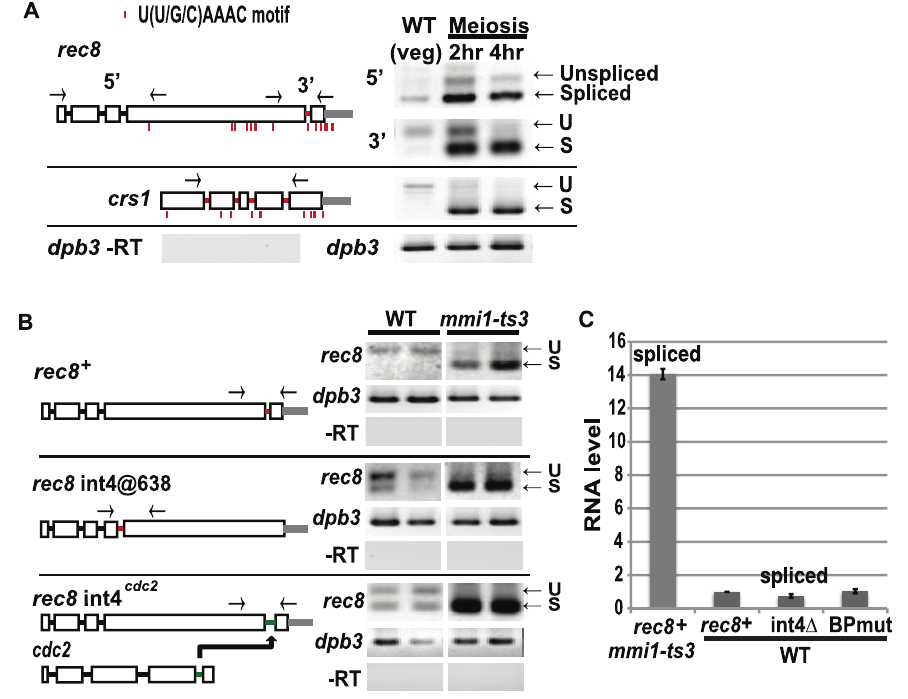
Figure 3. Splicing and stability of the rec8 transcript. (A) Splicing of endogenous rec8 and crs1 . Gene structures of rec8 and crs1 are drawn to scale. Box, exon; Black line, constitutively spliced intron; red line, regulated intron; grey line, 200 nt 3’ UTR; red bar, Mmi1 motif. The three introns clustered at the 5’ end of rec8 or the 3’-most 4 th intron were assayed with 5’ or 3’ primer pairs, respectively. All four introns of crs1 were assay with one primer pair. The dpb3 control indicates equal loading and the -RT control (no reverse transcriptase) shows the absence of contaminating genomic DNA. (B) Splicing of rec8 variants. A rec8 D (‘‘WT’’) or rec8 D mmi1-ts3 (‘‘ mmi1-ts3 ’’) strain were transformed with plasmids bearing the indicated rec8 constructs. Splicing of the 4 th intron was assayed by RT-PCR. Top, wild type rec8 + , middle, rec8 in which 4 th intron has been moved 1140 bp 5’ to be adjacent to the three unregulated introns (r ec8 int4@638 ), and bottom rec8 in which 4 th intron is replaced by the 4 th intron from cdc2 ( rec8 int4 cdc2 ). Results from two transformants are shown. (C) qPCR (triplicate assays for two transformants) of rec8 mRNA levels in a rec8 D (‘‘WT’’) transformed with plasmids expressing wild type rec8 + , rec8 with the 4 th intron deleted ( int4 D , mimicking spliced rec8 ), and rec8 in which the branch point sequence of 4 th intron is mutated so that splicing is blocked (BPmut, mimicking unspliced rec8 ). For comparison, rec8 levels from the rec8 + plasmid are shown in a rec8 D mmi1-ts3 strain. Error bar represents SEM.